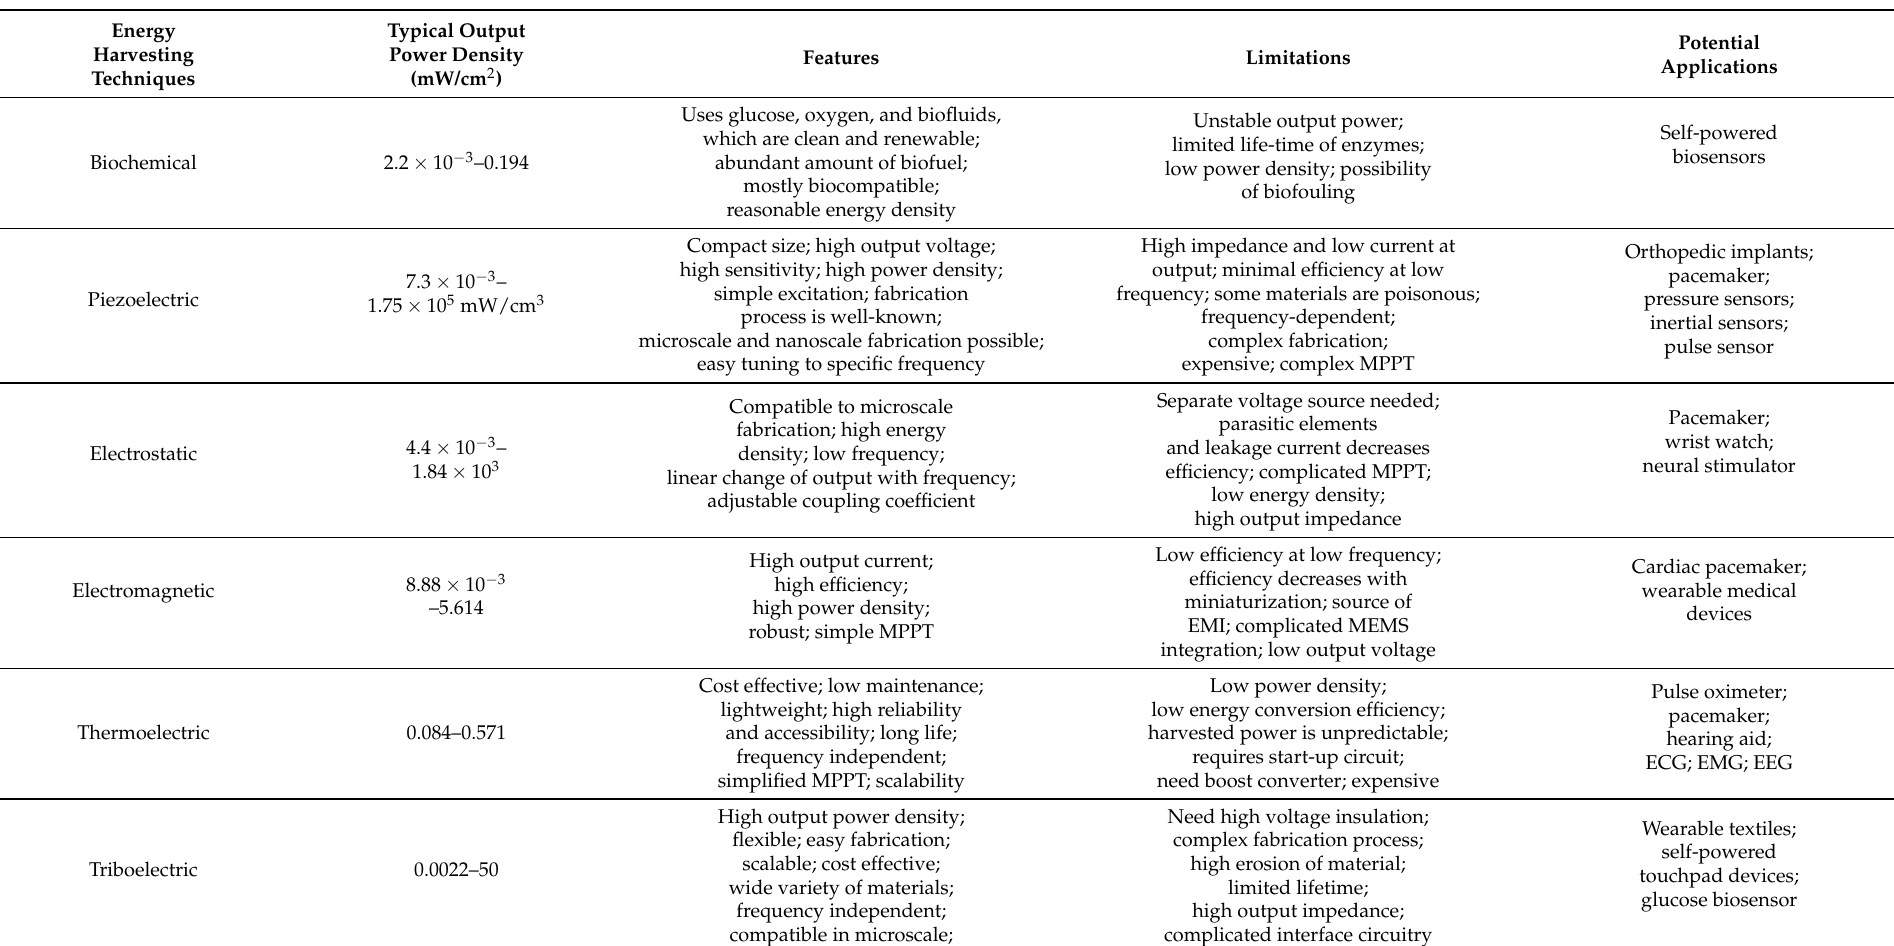
Table 6. Comparison of human-centric energy harvesting techniques considered for implantable and wearable medical